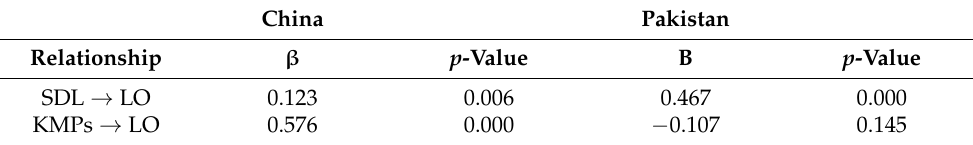
Table 10. Summary of Mediation